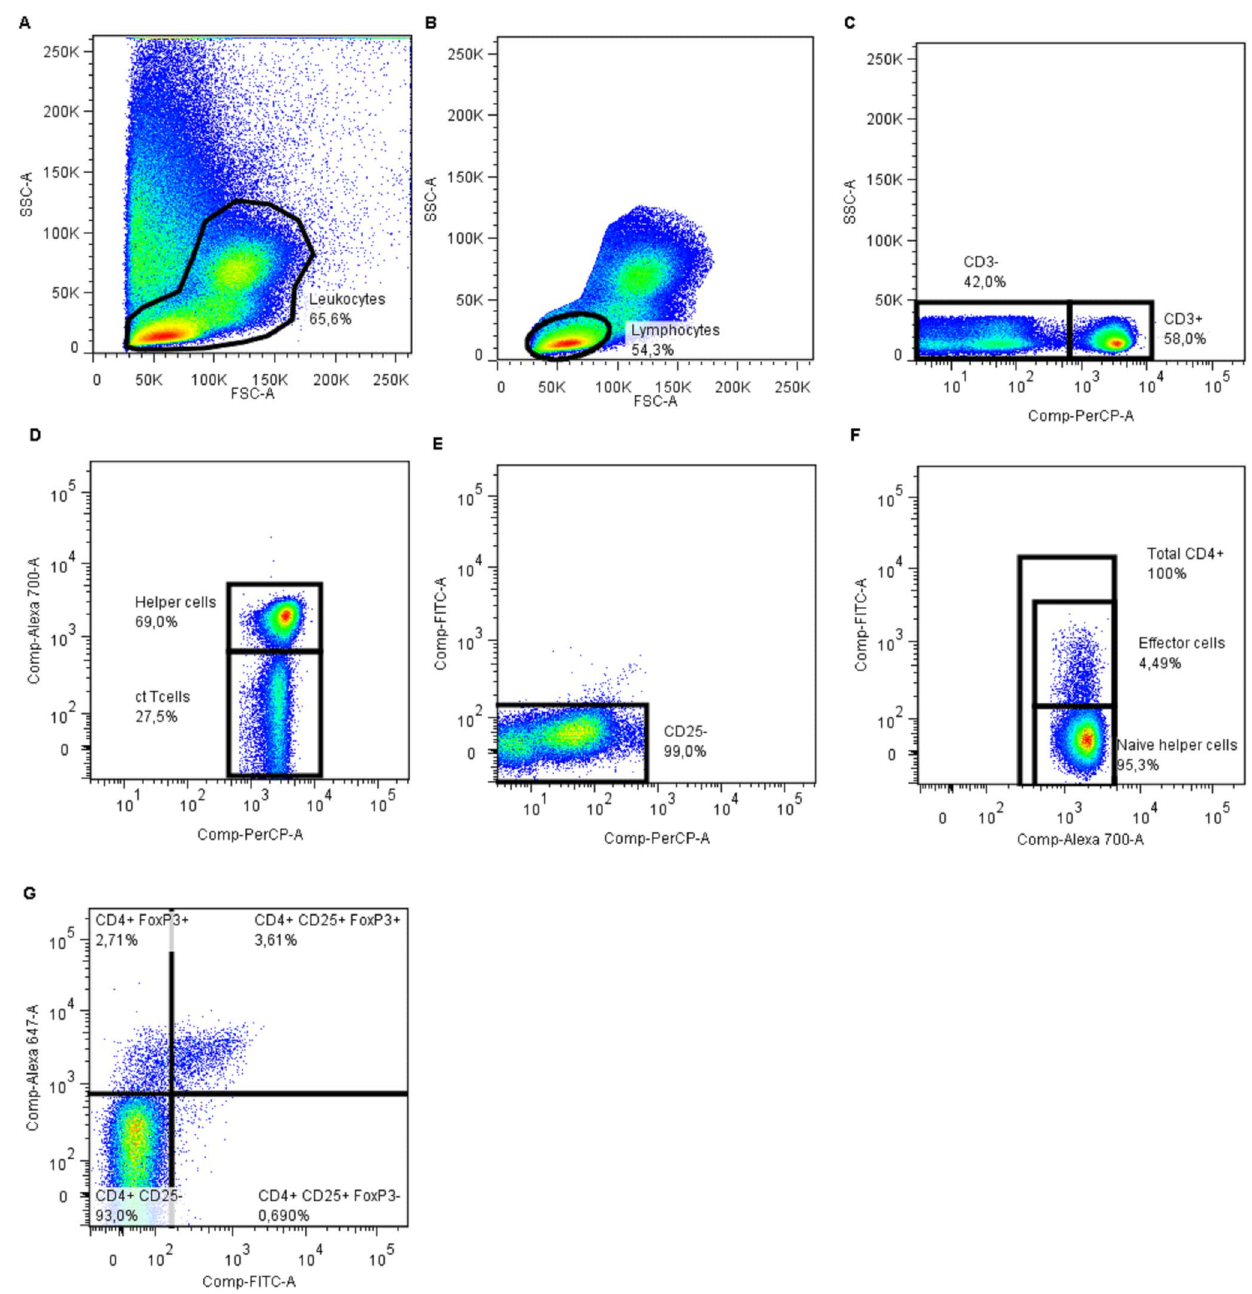
Figure 2. An representative example of a FACS analysis procedure to evaluate lymphocytes subpopulations. [A] A forward/sideward (FSC/SSC) scatterplot of all events in which leukocytes were identified. [B] The leukocyte gate was copied to a FSC/SSC scatterplot in which the lymphocytes are identified. [C] These lymphocytes are copied to a SSC/CD3-PerCP scatterplot to distinguish T-lymphocytes (CD3 + ). [D] The lymphocytes are further divided into helper (CD3 + /CD4 + ) and cytotoxic (CD3 + / CD4 + ; ct) T-cells in a CD3 PerCP/CD4 Alexa 700 scatterplot. [E] A CD3 PerCP/CD25 FITC scatterplot in which CD3 2 cells were copied to assess the gate for FITC-positivity. [F] This gate for FITC positivity was copied to a CD4 Alexa 700/CD25 FITC scatterplot to identify CD25 positive and negative cells; i.e. effector (CD3 + /CD4 + /CD25 + ) and naive helper T-cells (CD3 + / CD4 + /CD25 2 ). [G] A CD25 FITC/FoxP3 Alexa 647 scatterplot to identify the regulatory T-cell (CD3 + /CD4 + /CD25 + /FoxP3 + ; Treg) positive population. FSC/SSC plot to identify lymphocytes. The lymphocyte gate was copied to a CD161a/SSC plot (CD161a or NKR-P1a is an activating receptor and present on all NK-cells); a gate was set on CD161a + . These cells were identified as NK-cells. Further, mean